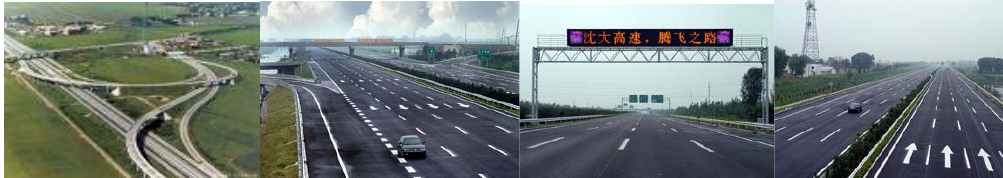
Figure 4. Shen-Da